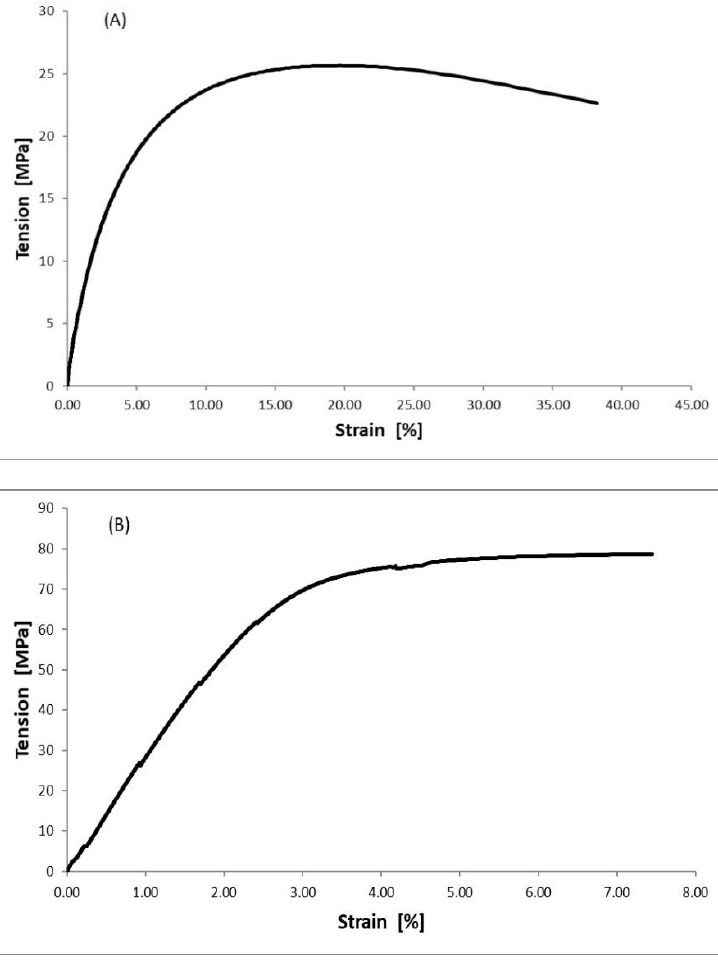
Figure 4. Examples of tensile strength curves for: ( A ) PE7M; ( B ) PBT7A.